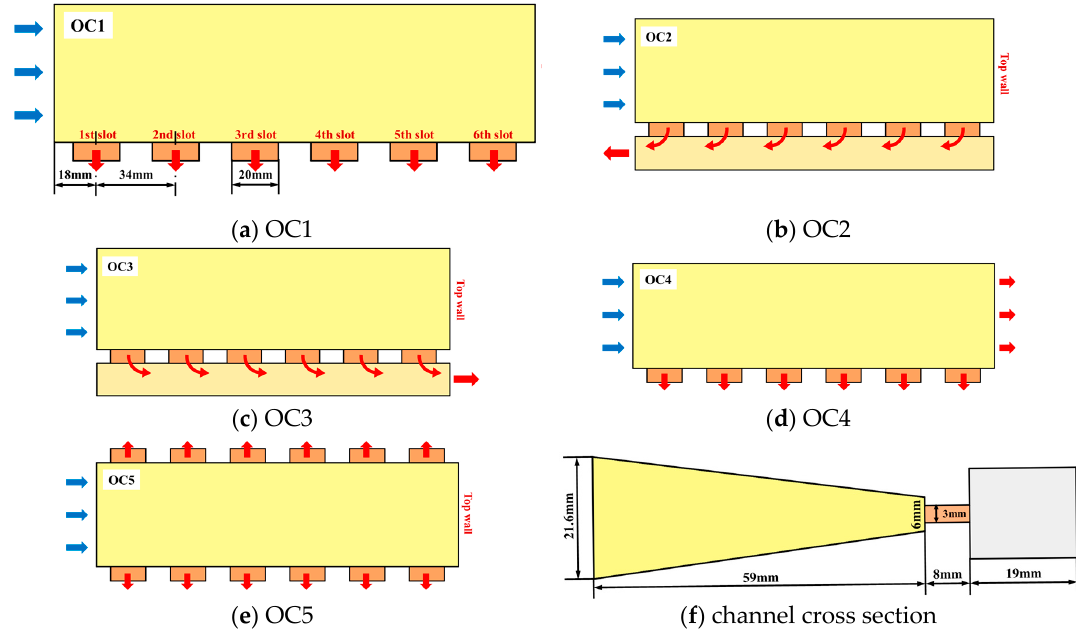
Figure 2. Structures and parameters of different channel outlet configurations.